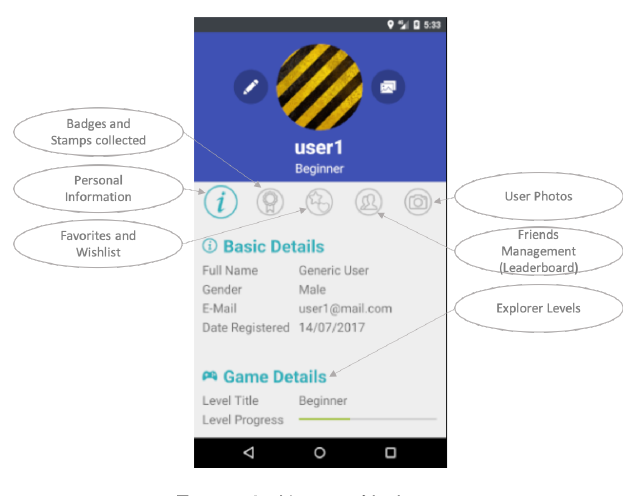
Figure 4. User profile layout.